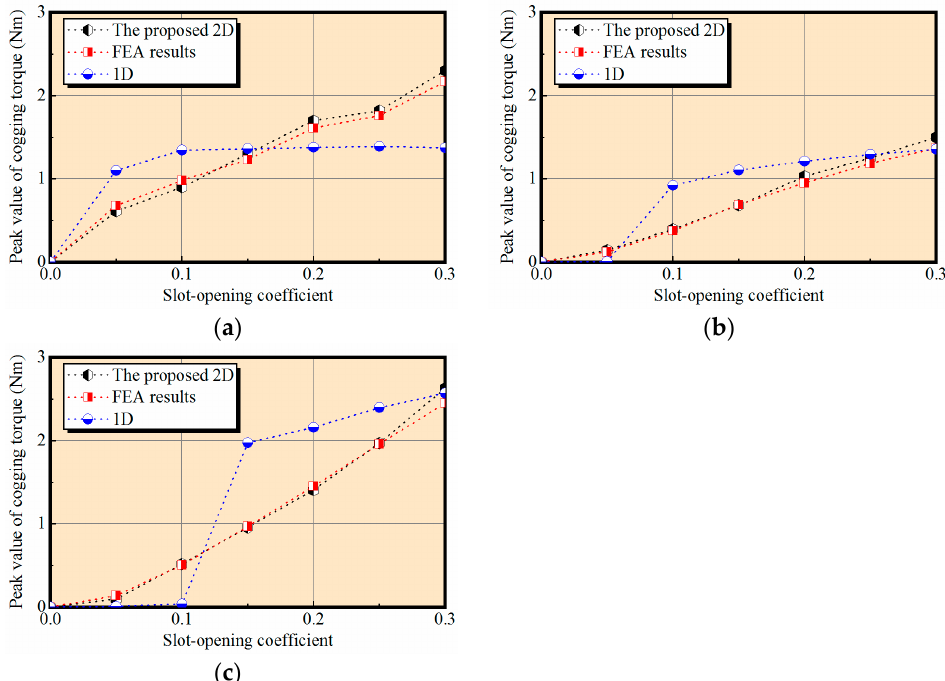
Figure 15. The cogging torque peak value trends with the varying slot-opening coefficient, when pole-arc coefficient α = 0.63 : ( a ) 8P12S. ( b ) 8P36S. ( c ) 8P48S. pole-arc coefficient α p = 0.63: ( a ) 8P12S. ( b ) 8P36S. ( c ) p